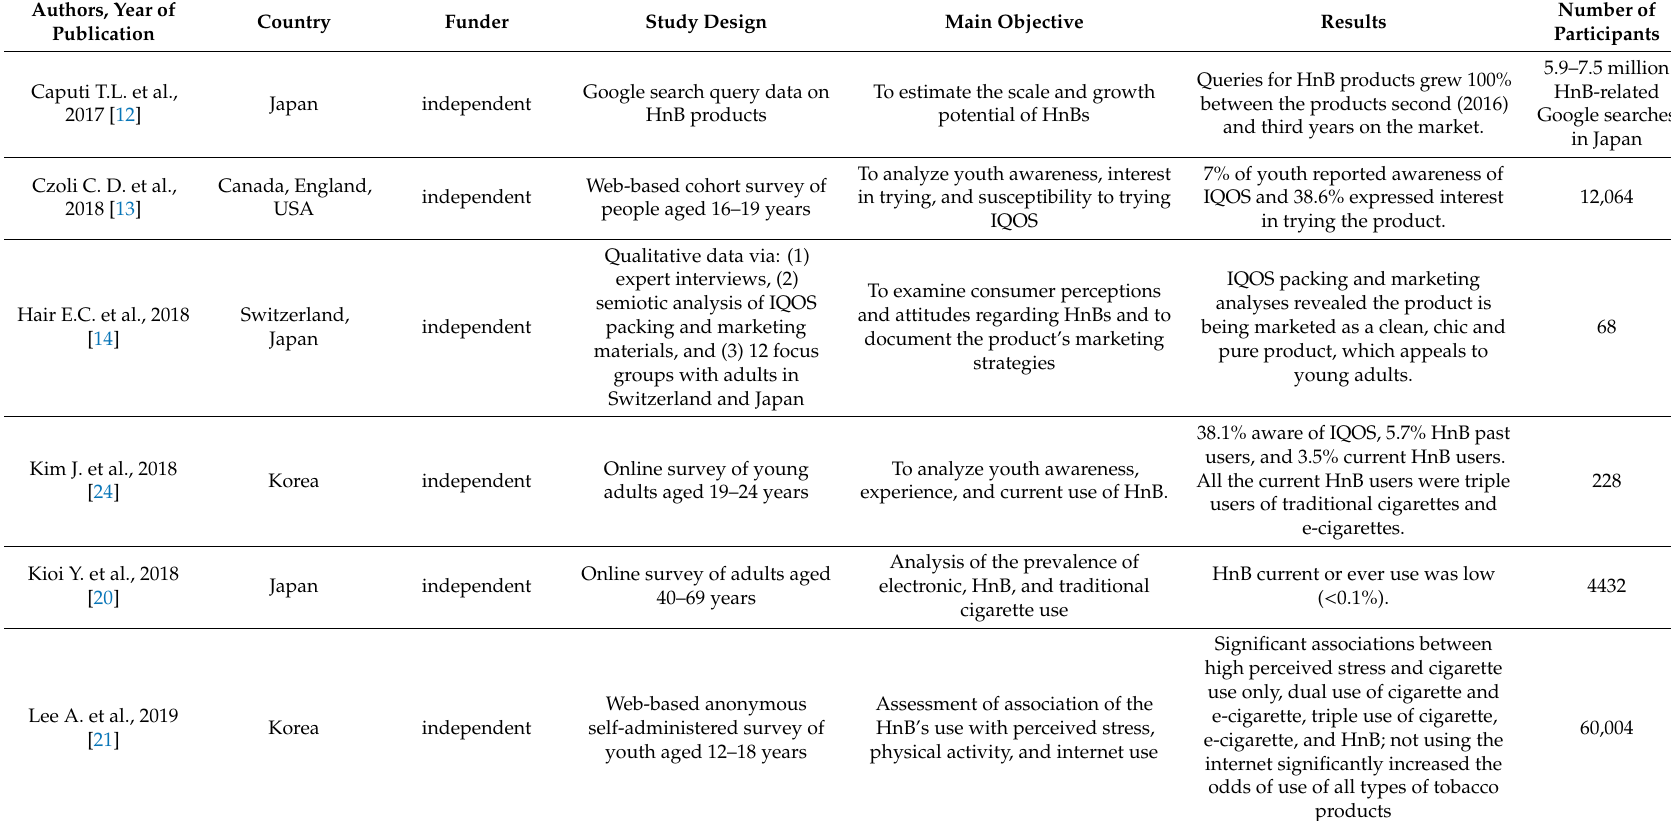
Table 1. Studies included in the